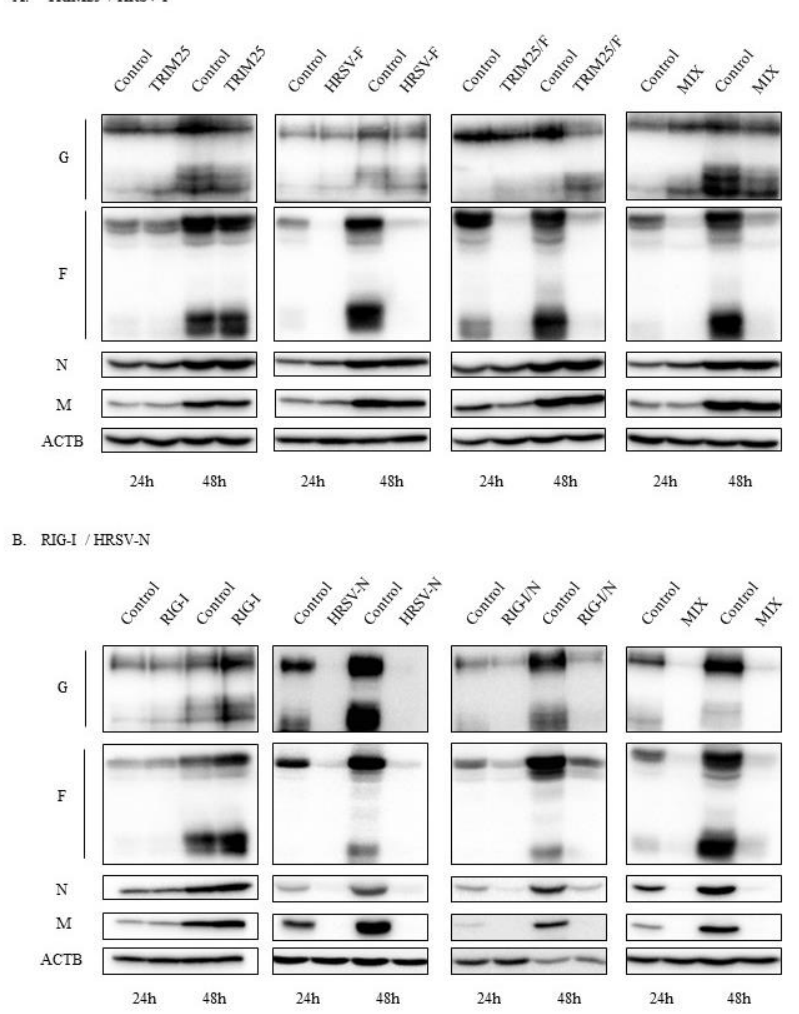
Figure 4. Levels of HRSV proteins (G, F, N, and M) in cells transfected with different siRNAs. ( A ) Cells transfected with the siRNAs TRIM25, HRSV-F, TRIM25/HRSV-F or a combination of TRIM25 plus HRSV-F (MIX). ( B ) Cells transfected with the siRNAs RIG-I, HRSV-N, RIG-I/HRSV-N or a combination of RIG-I plus HRSV-N (MIX). Cells were transfected with the siRNAs and infected 24 h later at an MOI of 3. Protein extracts were done at 24 and 48 hpi. The Western blot was utilized to analyze the cells using specific antibodies. The levels of β-actin (ACTB) are shown for comparison.